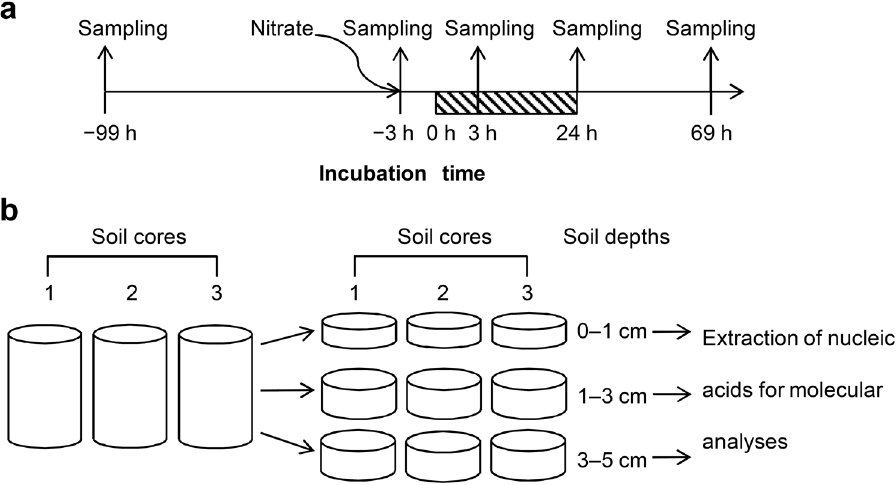
Figure 1. Sampling time ( a ) and dissection ( b ) of soil cores. The shadowed region indicates the waterlogging period. Arrows indicate the time of soil sampling and addition of